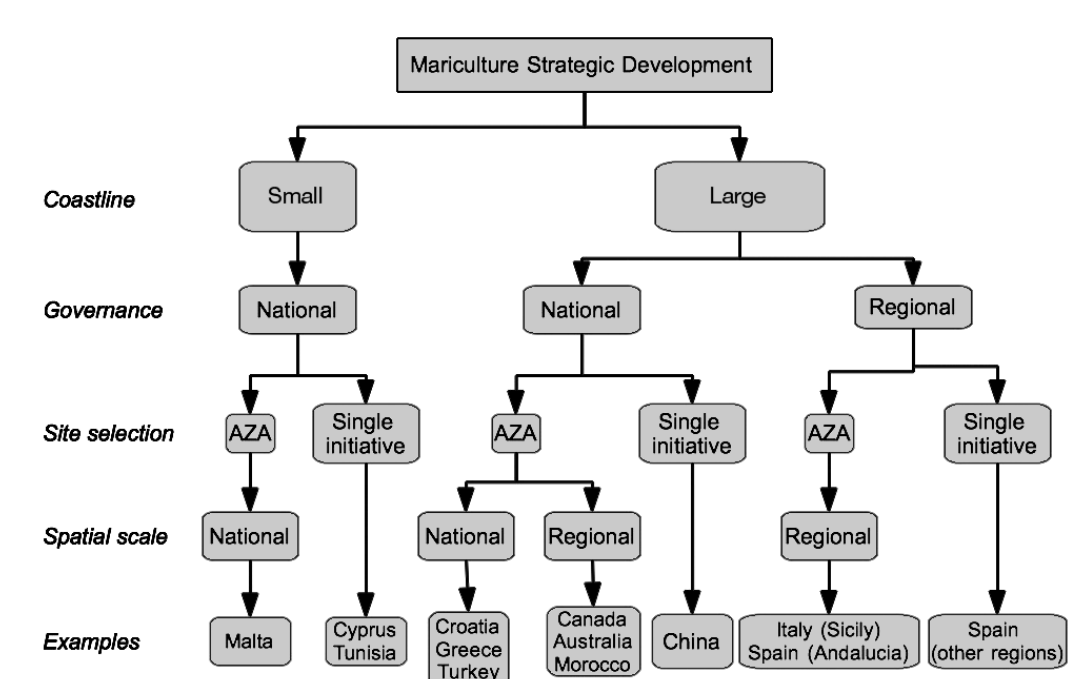
Fig. 1. Classification of case studies of Allocated Zones for Aquaculture (AZAs) included in the present study, relative to (1) the length of the coastline of the country, (2) the governance level, (3) the site selection procedure (based on previous spatial planning or relying on private single initiative) and, in the event of spatial planning, (4) the spatial scale of AZA